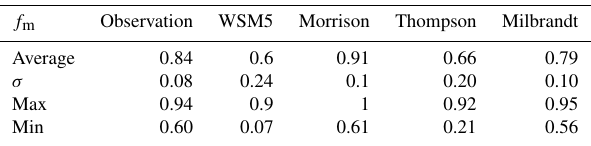
Table 6. Statistics over the flight tracks on the mixed-phase ratio f m = LWC / (LWC + SWC) for temperatures T > − 15 ◦ (see text for details).